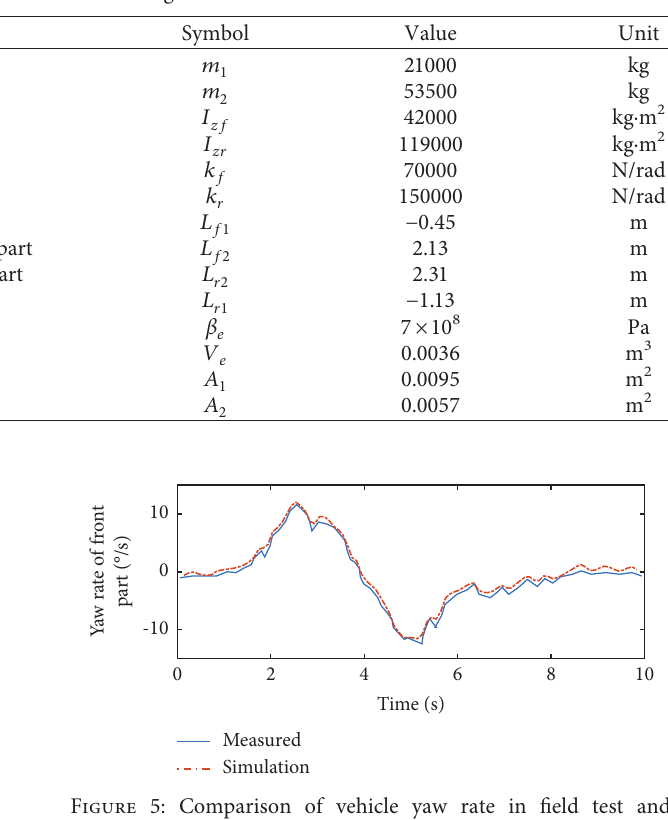
Table 1: Parameters and value in the single-track model.